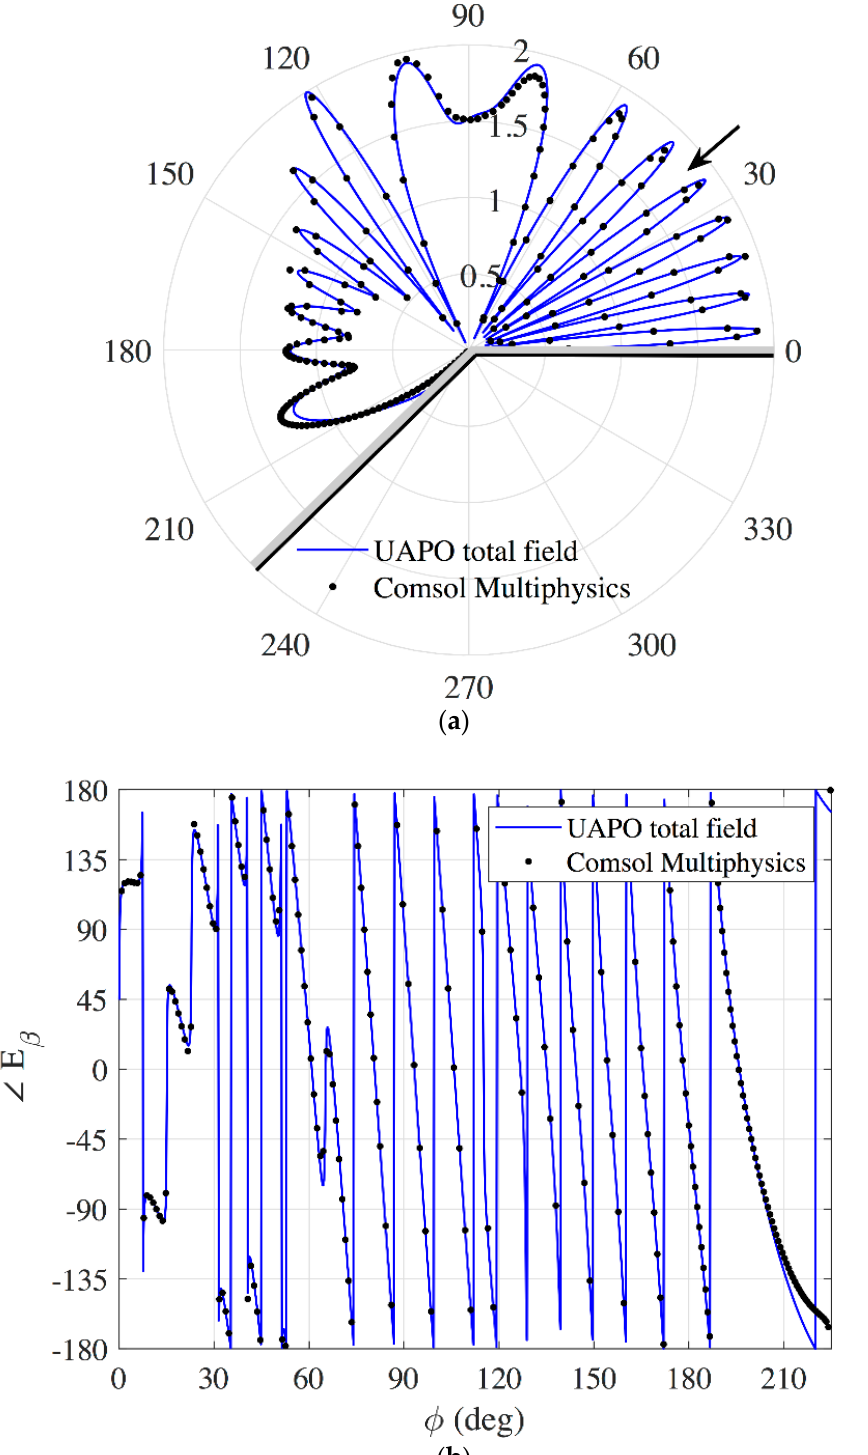
i = i = = 1, E i = 0. 1 , E 0 . ( a ) φ (cid:48) β (cid:48) b ' f '